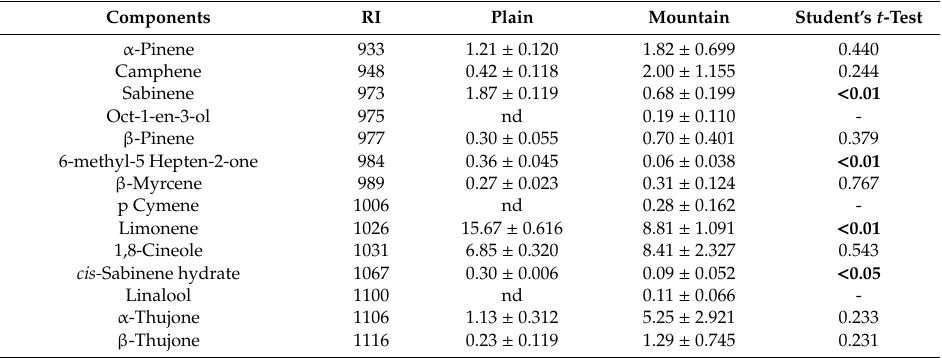
Table 6. Chemical composition (%) of essential oils of lemon verbena plants grown at di ff erent altitudes (plain vs. mountain). Data are expressed as means ± SE (n = 3), and significant di ff erences ( p < 0.05, p < 0.01, p < 0.001) in bold between treatments are indicated by Student’s t -test p